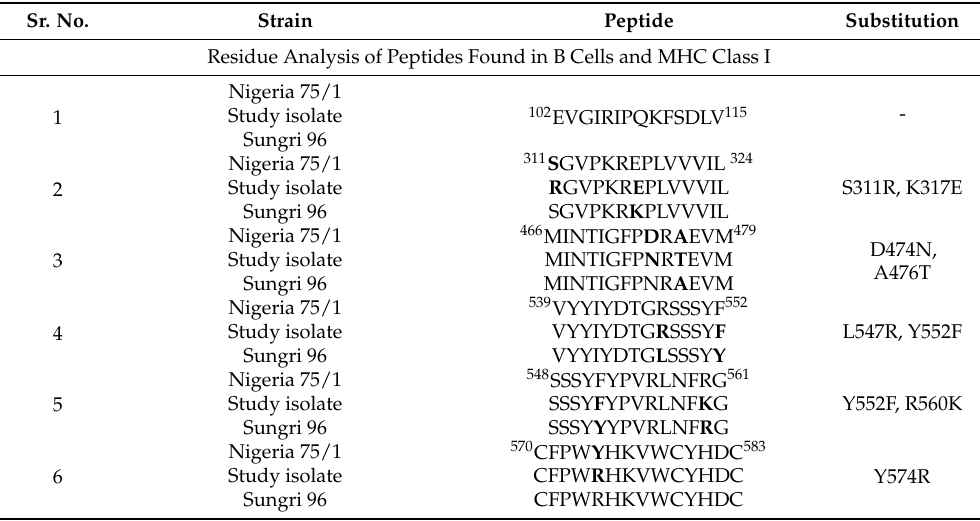
Table 3. Comparative mutational analysis of hemagglutinin protein of studied isolates and vaccinal strains (Nigeria 75/1 and Sungri